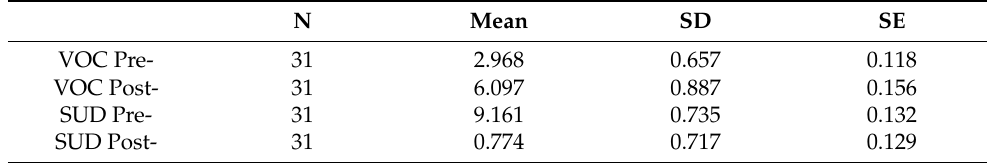
Table 7. Pre- and post-intervention comparison of secondary outcome measure. N Mean